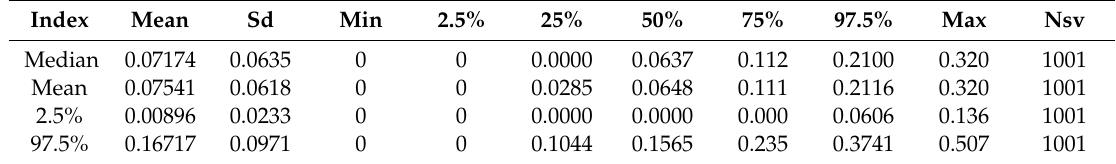
Table 8. The results of the model.